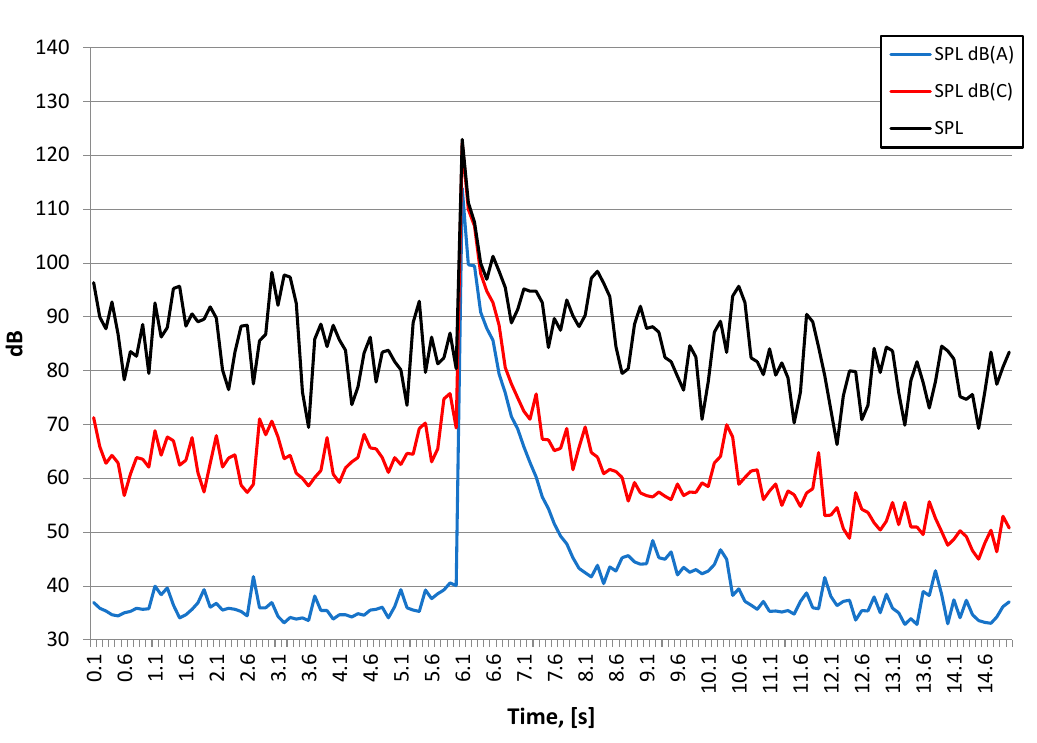
Figure 21. Waveforms of Sound Pressure Level: SPL A-weighting, SPL C-weighting, SPL (unweighted)–250 g explosive charge on the surface-Station 3.